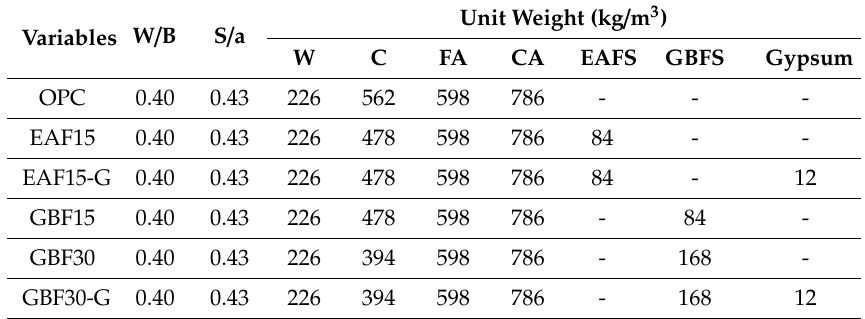
Table 2. Mix designs of